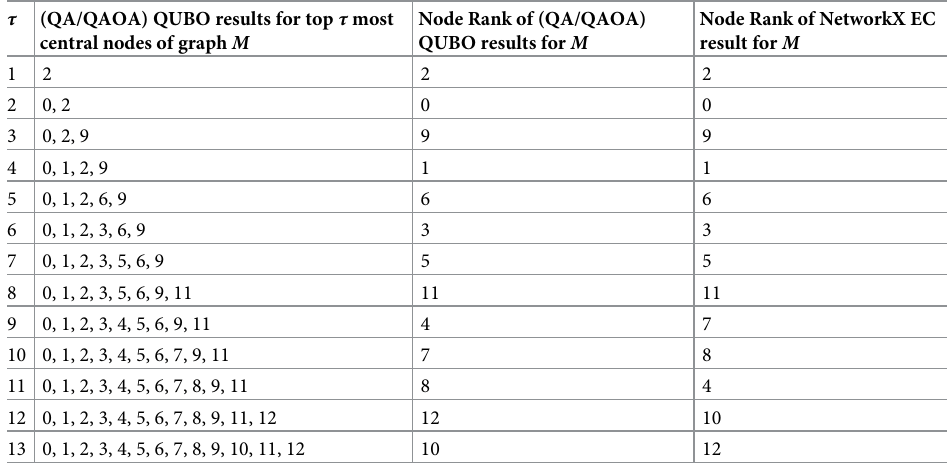
Determining node rank from the QUBO result obtained from D-Wave (QA) and IBM-Q (QAOA) using symmetric difference of results for τ = 1 to τ = n . In column 4, the ith in rank is determined by taking the difference of the result for τ = i and τ = i − 1 e.g. the 1st (most central) node 2 is determined by implementing the QUBO for τ = 1, the 2nd is determined by taking the difference between the result of τ = 2, {0, 2} and the result of τ = 1, {2}, i.e. {0, 2}\{2} = {0}, implying node 0 is ranked second in